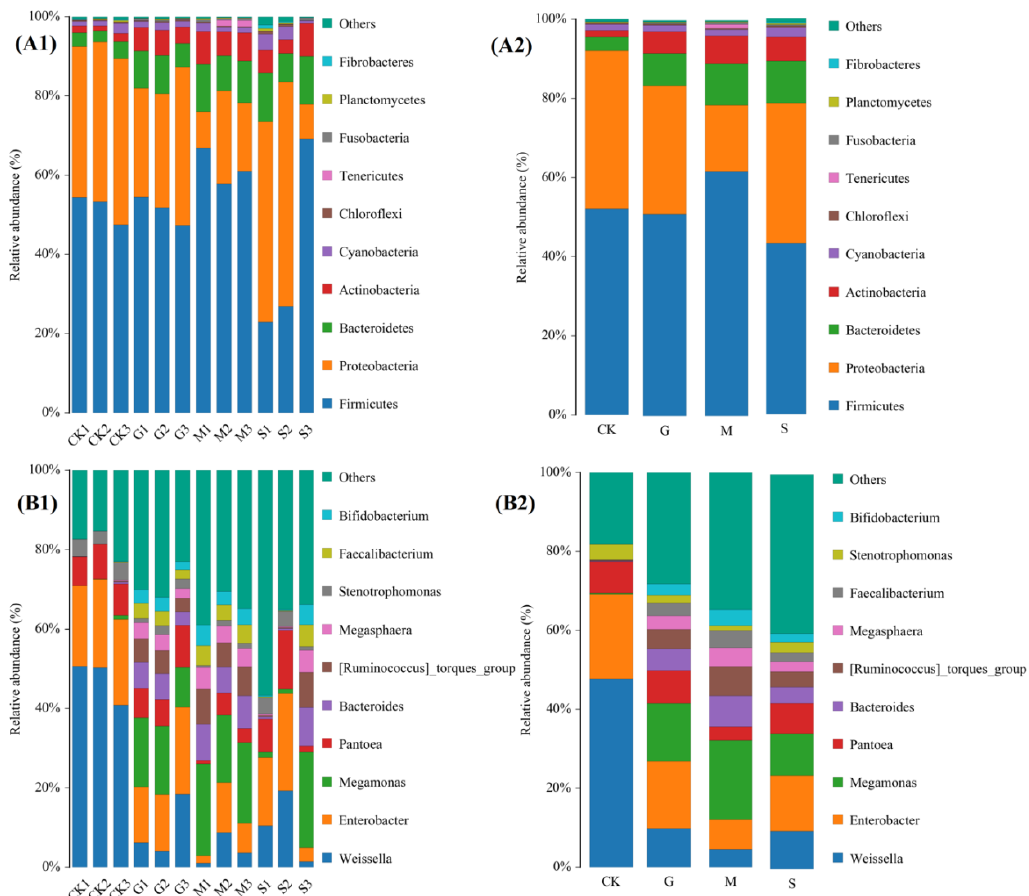
Figure 3. The bacterial abundance at the levels of phylum and genus in stylo silage. ( A1 ) Relative abundance of bacteria at the phylum level of each sample; ( A2 ) Relative abundance of bacteria at the phylum level of each group. ( B1 ) Relative abundance of bacterial at the genus level of each group; ( B2 ) Relative abundance of bacteria at the genus level. CK, control; S, sucrose; G, glucose; M, molasses.